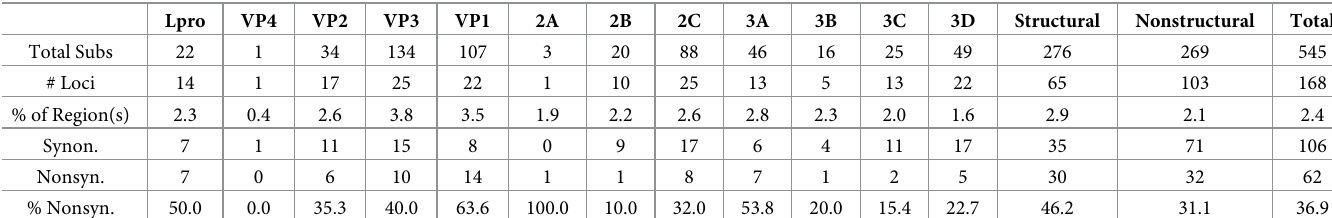
Table 1. Distribution of consensus-level nucleotide substitutions in sample viruses across the FMDV coding region in 52 sampled